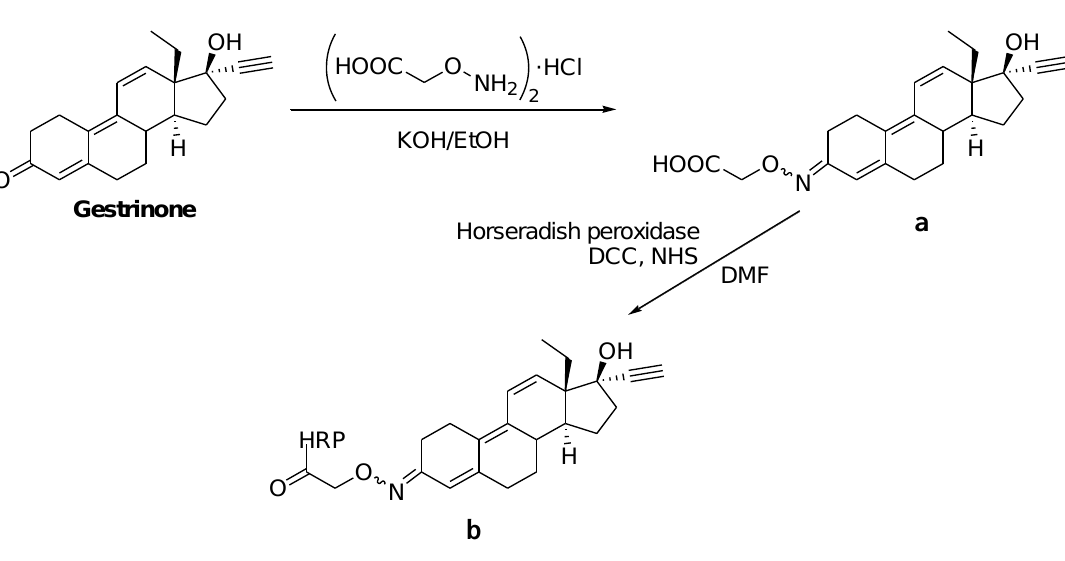
Figure 3. Synthesis of gestrinone oxime hapten ( a ) and gestrinone oxime hapten-horseradish peroxidase (HRP) conjugate ( b ).